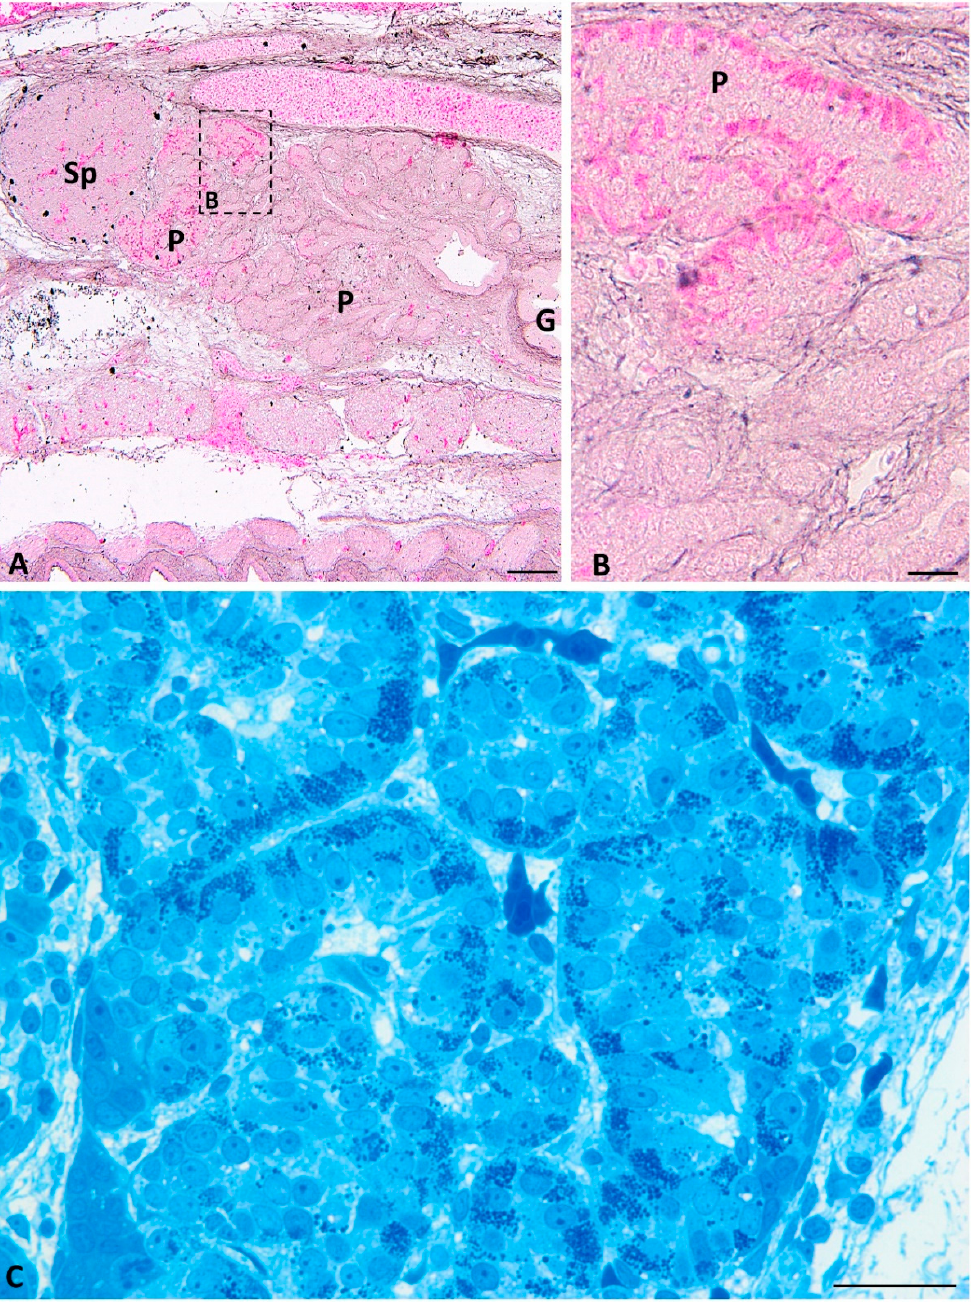
Figure 2. Transverse sections through the pancreas of the grass snake embryo at developmental stages IV–VIII stained with phloxine and gallocyanin ( A , B ) and methylene blue ( C ). ( A ) Scale bar = 100 µ m. ( B , C ) Scale bar = 20 µ m. ( B ) Magnification of the frame in ( A ). Note presumptive islets. Abbreviations: G: gut; P: pancreas; Sp: spleen.